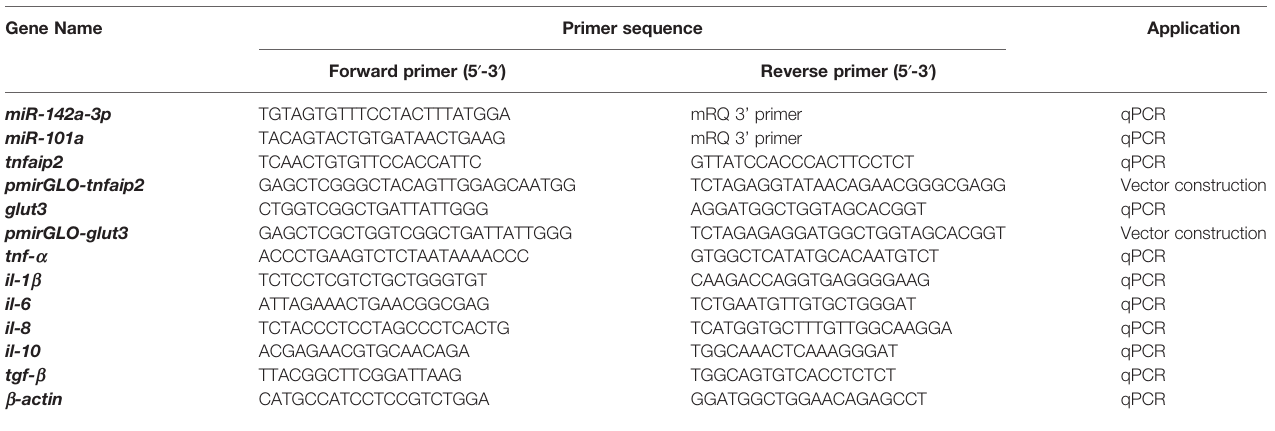
TABLE 1 | Primer sequences used in the present